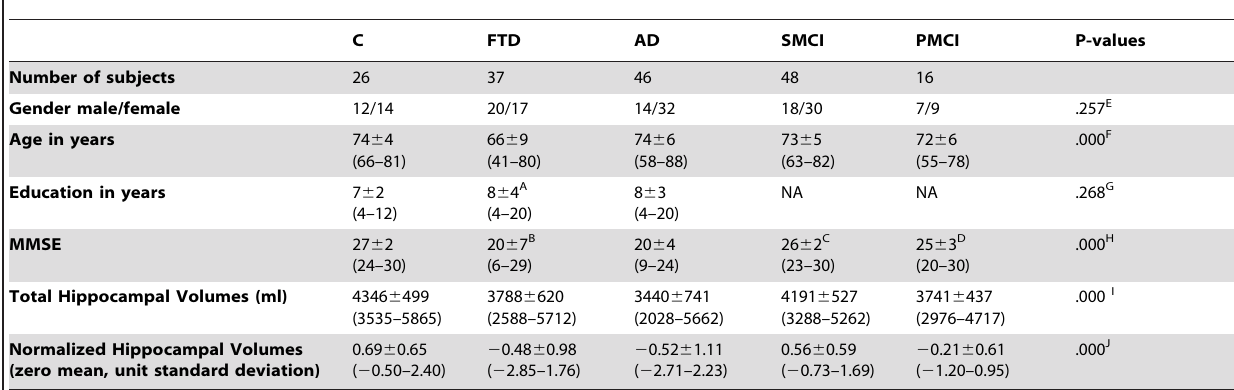
Table 1. Demographic and clinical data of study